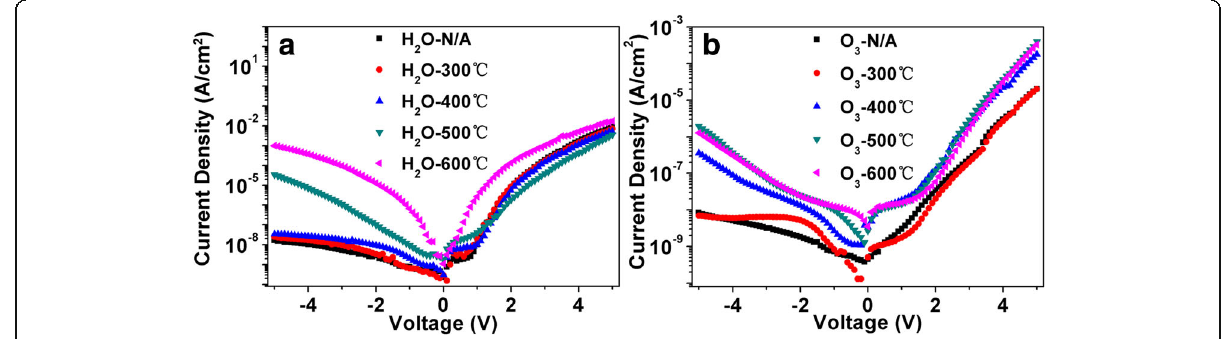
Fig. 4 I - V characteristics of MOS capacitors under different annealing temperatures. a H 2 O as the oxidizer. b O 3 as the